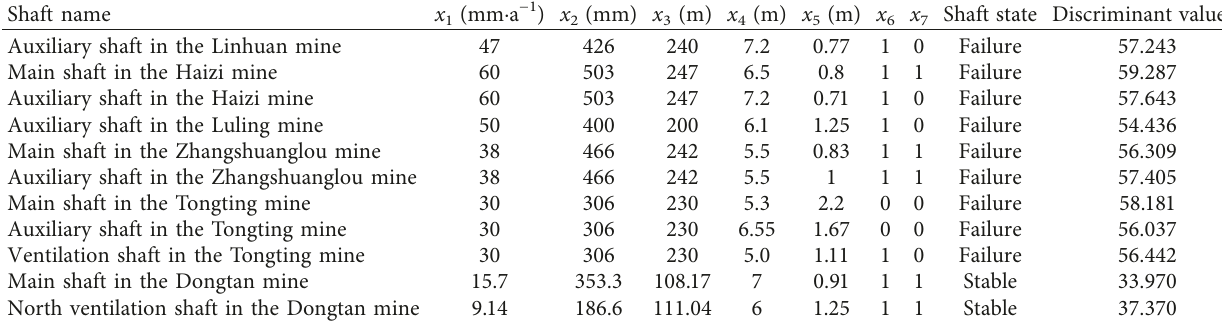
Table 6: Training sample of shaft stability.